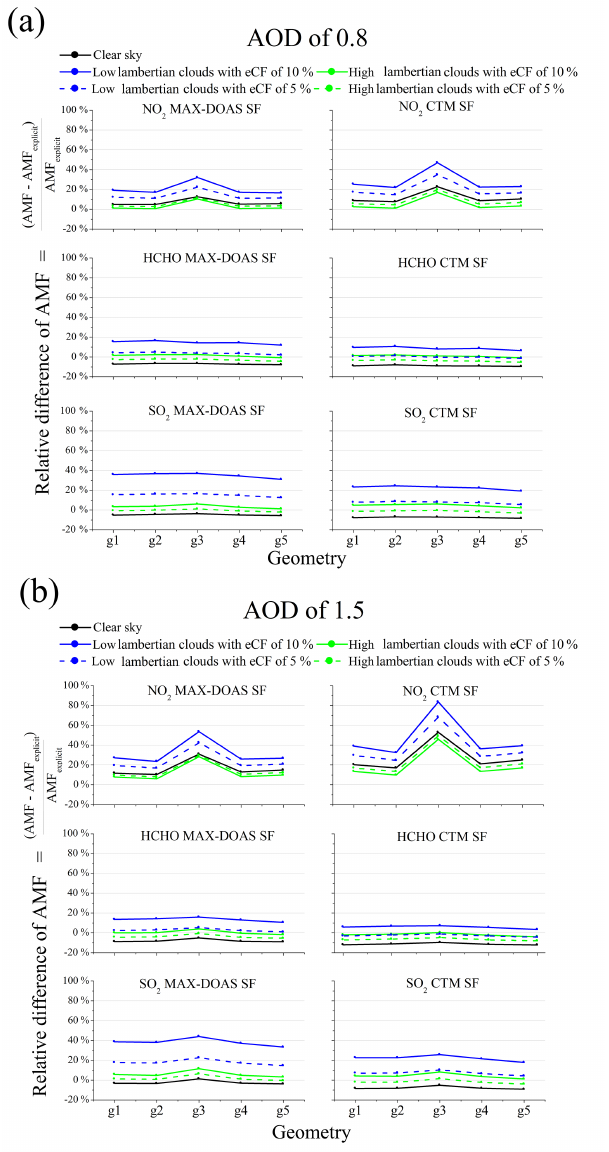
Figure 17. Relative differences between AMFs calculated for dif- ferent cloud assumptions (for detail see text) and AMFs for explicit aerosol profiles for three TGs. The labels at the x axis indicate five different observation geometries (see Table 2). The MAX-DOAS and CTM SFs are used for the calculations shown in the left and right column. Explicit aerosol profiles of AOD of 0.8 and 1.5 are used in (a) and (b) ,